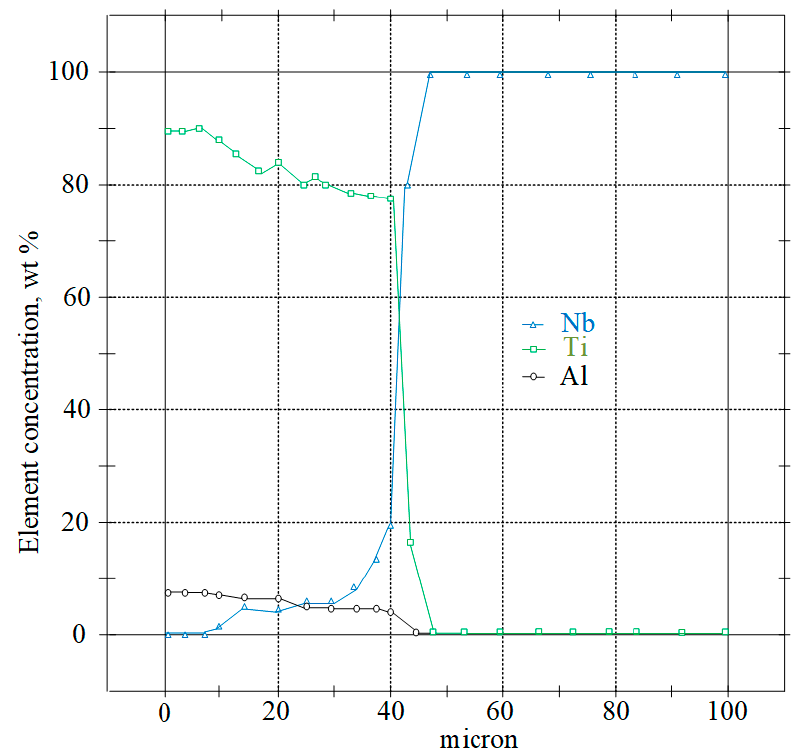
Figure 17. Diffusion welding scheme 12KH18N10T+Cu+Nb+VT-14.